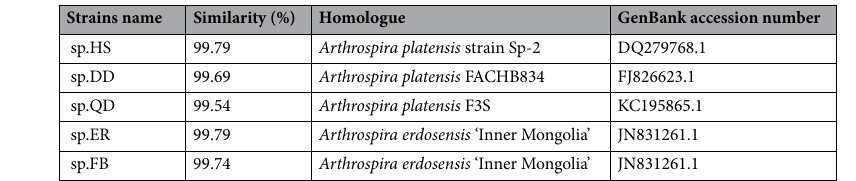
Table 1. Results of blastn in the GenBank